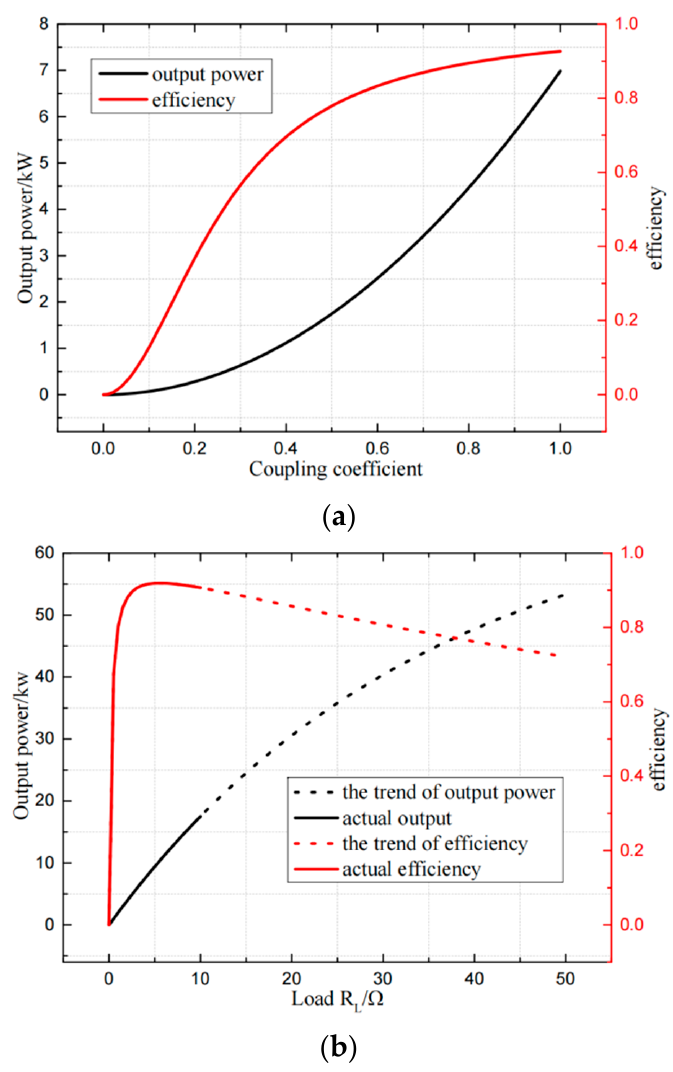
Figure 12. Power and efficiency characteristic curve of dual-LCL: ( a ) coupling coefficient- power/efficiency, ( b ) load-power/efficiency.